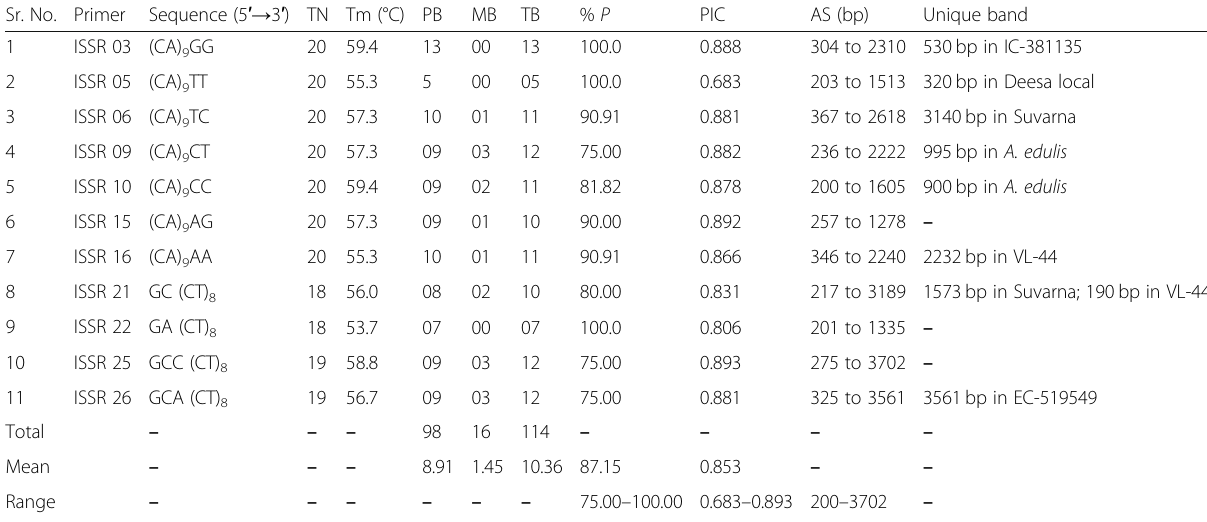
Table 2 Particulars of polymorphic ISSR primers used in the study Sr. No. Primer Sequence (5 ′ → 3 ′ ) TN Tm (°C)